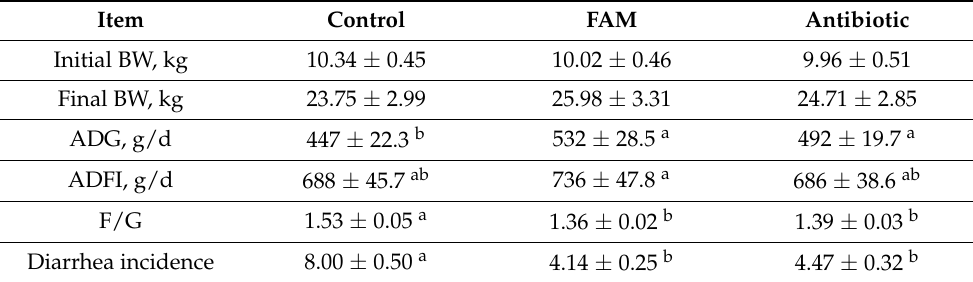
Table 1. Growth performance of different experimental